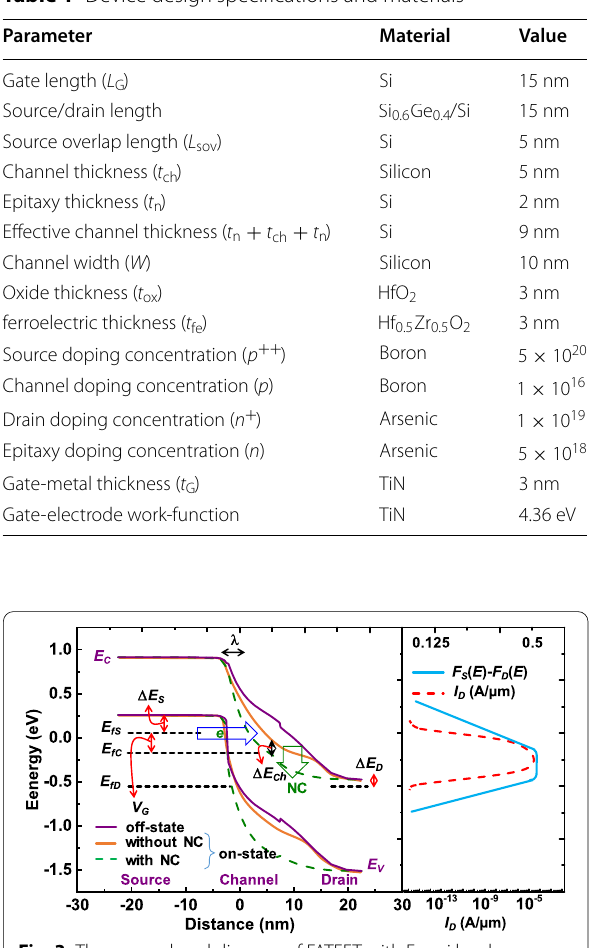
Fig. 3 The energy band diagram of FATFET with Fermi levels (evaluates the performance of tunneling), NC effect (induce of V fe ), extracted current density or I D , and difference between Fermi levels of source ( F S ( E ) ) and drain ( F D ( E ) ). Induced V fe amplifies V int and reduces the (cid:31) ; proportionally steep SS and high I D are